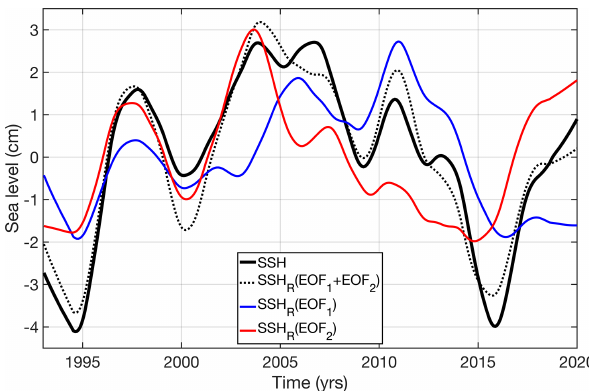
Figure 6. Time series averaged over 5–45 ◦ W and 55–65 ◦ N (as in Chafik et al., 2019): detrended SSH (solid black), SSH R recon- structed using the combination of EOF 1 and EOF 2 (dotted black), SSH R reconstructed using EOF 1 (blue), and SSH R reconstructed using EOF 2 (red).